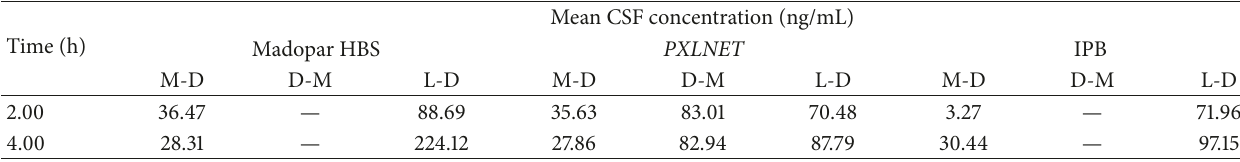
Table 6: Mean cerebrospinal fluid concentration after oral administration of Madopar HBS capsules, PXLNET ,and IPB matrices.